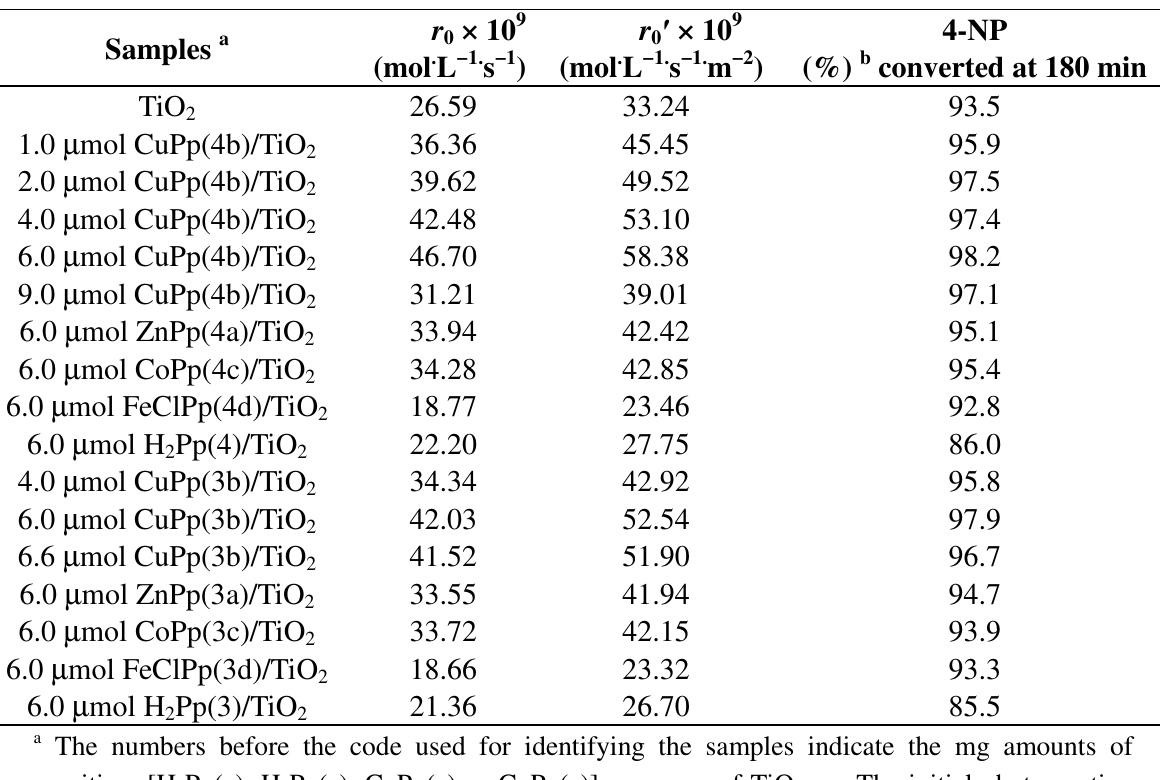
Table 2. List of the samples used together with the initial photoreaction rates, and the conversion (%) 4-NP after 180 min of irradiation time.